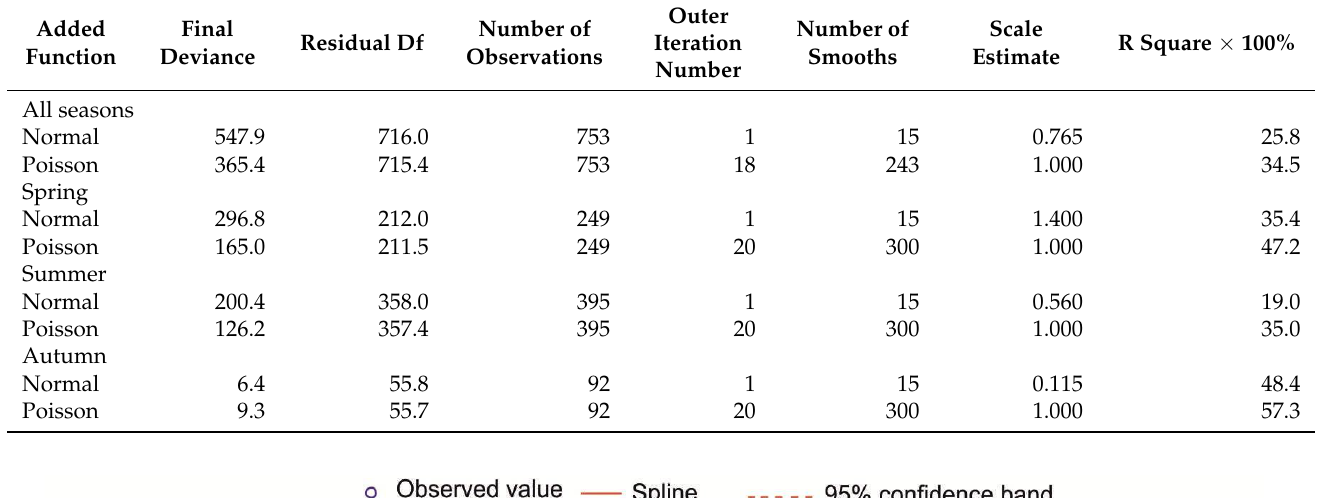
Table 5. Summary statistics for GAM to predict Chl-a patterns in relation to selected climatic pre-